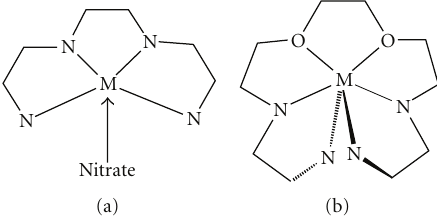
Scheme 2: A schematic representation of the coordination of the Schi ff base ligands used, to lanthanides. (a) References 18–21, (b) This